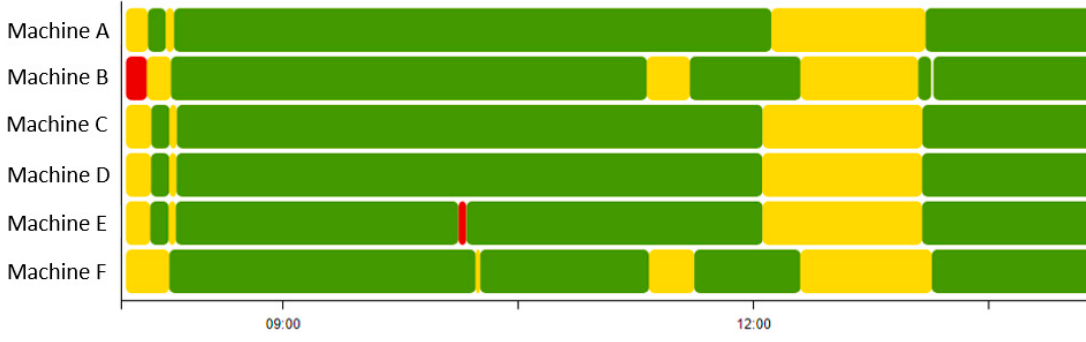
Figure 1. Examples of machine operating processes.